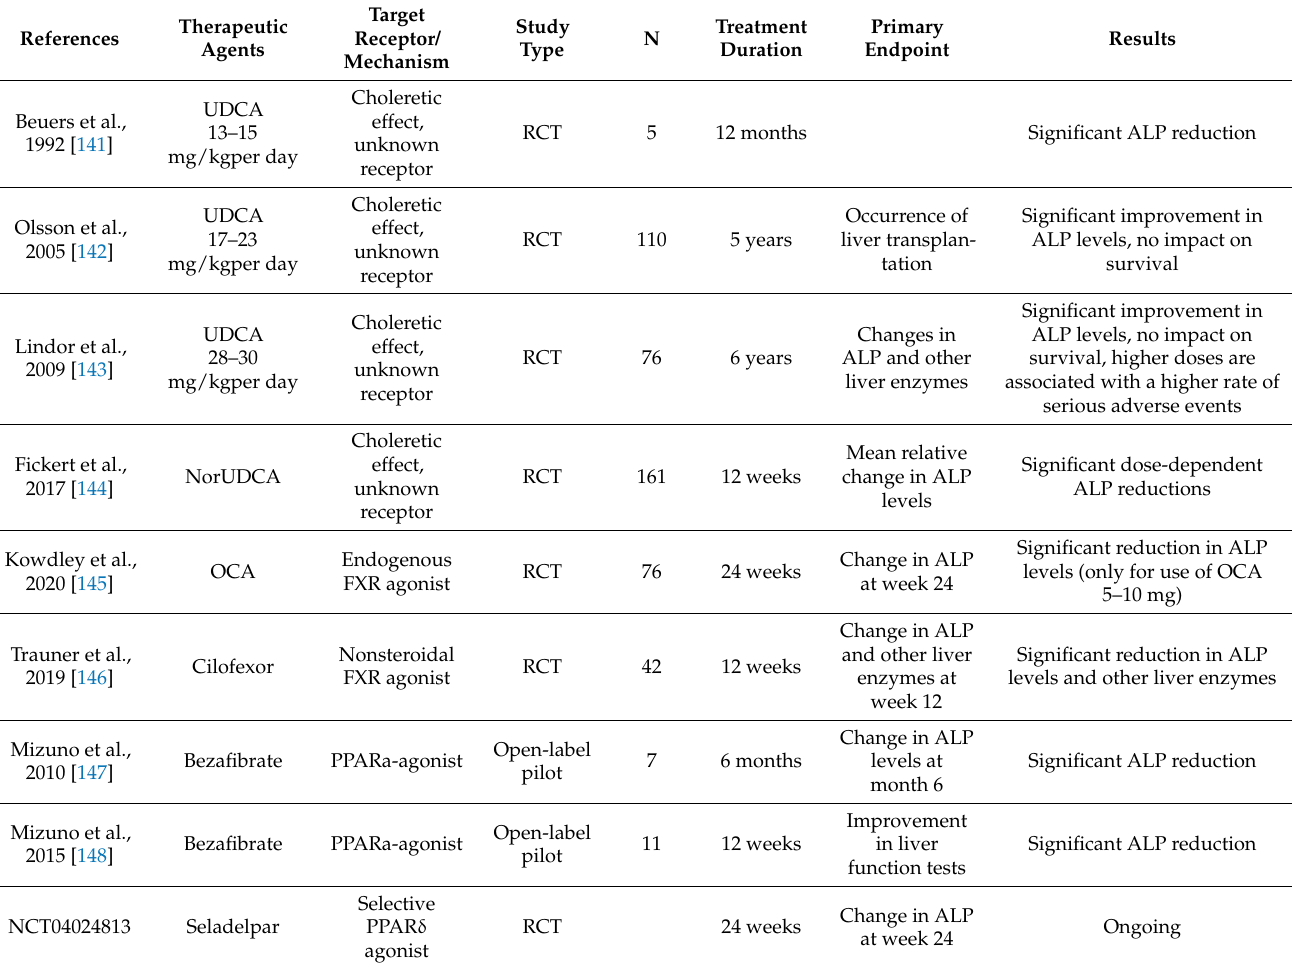
Table 3. Overview of a selection of therapeutic agents targeting bile acid pathways and their study